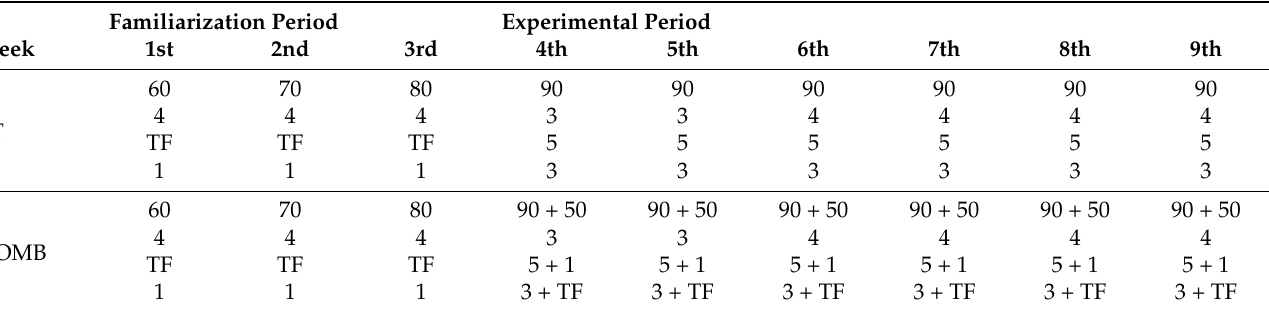
Table 1. Training schemes in ST and